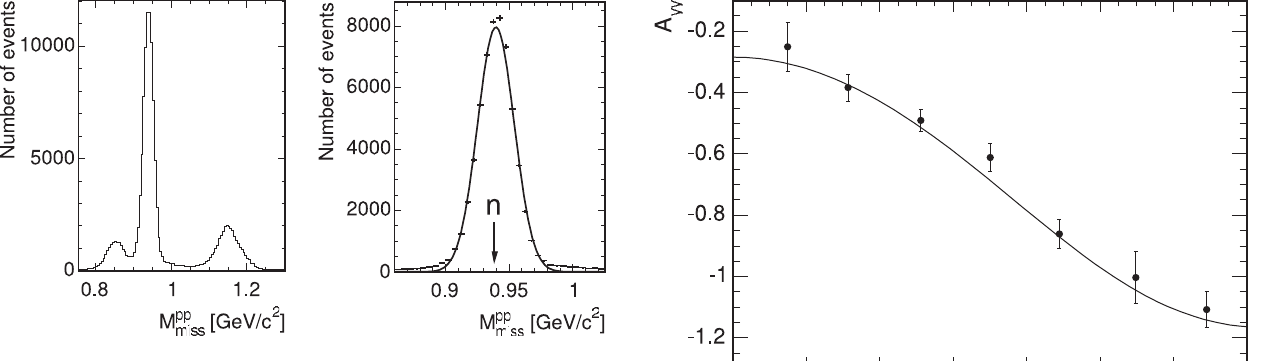
extracted yy < 1 MeV . pp